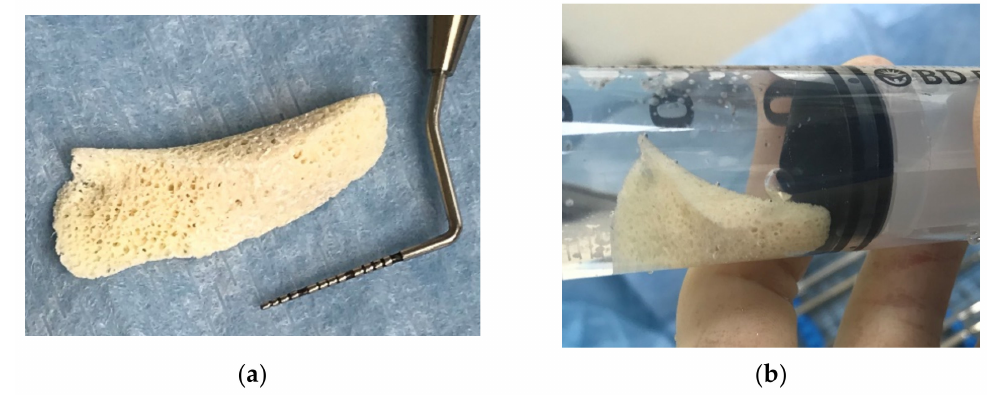
Figure 6. Size of the ACBB ( a ) and hydration of the bone block ( b ). The bone block fitted precisely without a need of for adaptations. Three ACE TruFix ® 1.2-mm × 6-mm screws were used to fix the block and subsequently covered with a non-crosslinked collagen membrane (CopiOs ® Pericardium Membrane, Zimmer Biomet Dental). Simple interrupted sutures were applied to provide a tension-free flap closure (Figures 7a–c and 8a,b). After surgery, the patient was instructed to not wear her partial prosthesis and to rinse the oral cavity with chlorhexidine solution for one minute twice a day. To prevent postoperative infection, an additional antibiotic administration with clindamycin for 5 days was prescribed (300 mg every 8